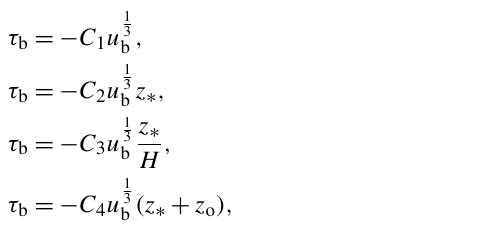
Table 1. The coefficient values were chosen to give